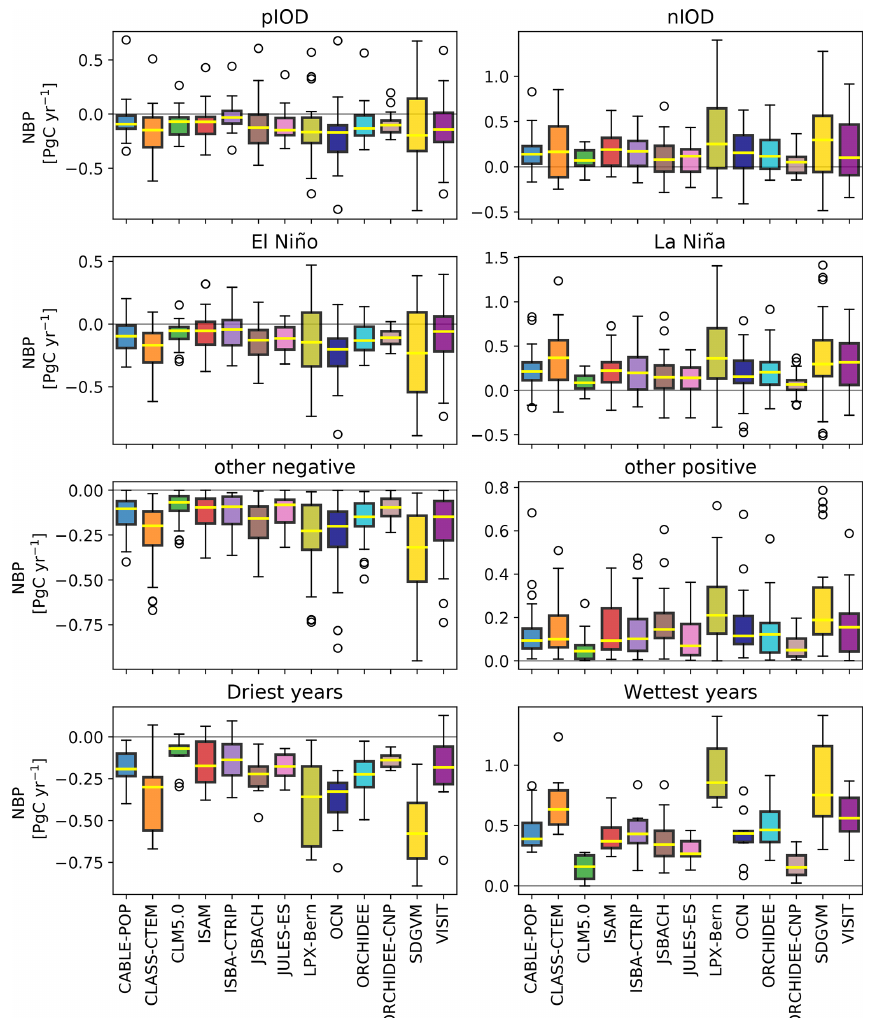
Figure 3. Net biome production (NBP) during positive IOD (“pIOD”), negative IOD (“nIOD”), El Niño, and La Niña events (see Table B2). All negative NBP values that are associated with neither pIOD nor El Niño are classified as “other negative”; all positive NBP values that are associated with neither nIOD nor La Niña events are classified as “other positive”. “Driest years” shows NBP values associated with the 10 driest years, and “wettest years” shows NBP values associated with the 10 wettest years (based on precipitation anomalies averaged over Australia). We define the first month of the year as July, and the last month of the year is defined as June. Note that the y axis limits differ between the